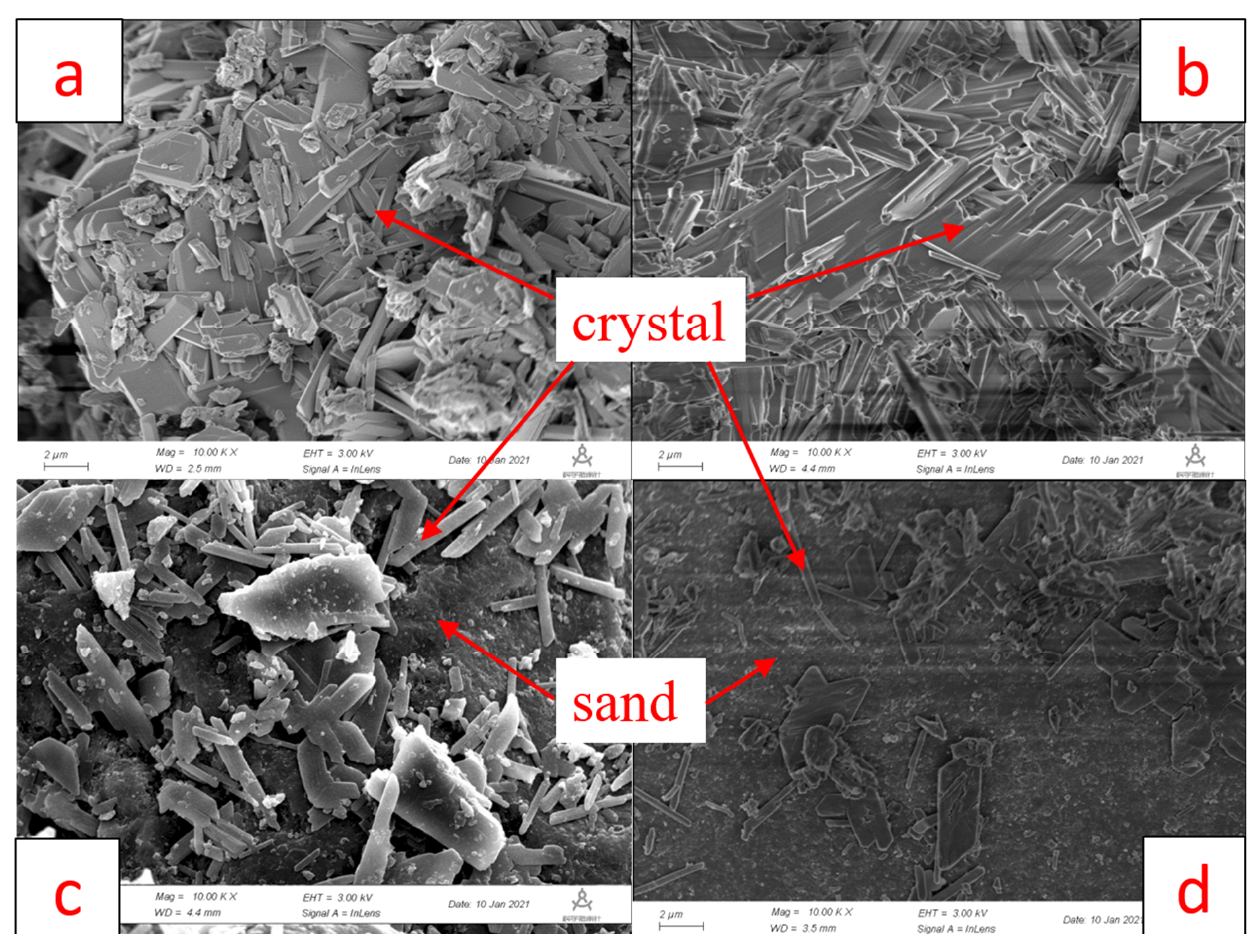
Figure 9. Crystal morphology magnified 10,000 times under the scanning electron microscope. ( a ) Natural 20-day curing condition; ( b ) 400 W–500 min curing condition; ( c ) 1200 W–300 s curing condition; ( d ) 2000 W–200 s curing condition.